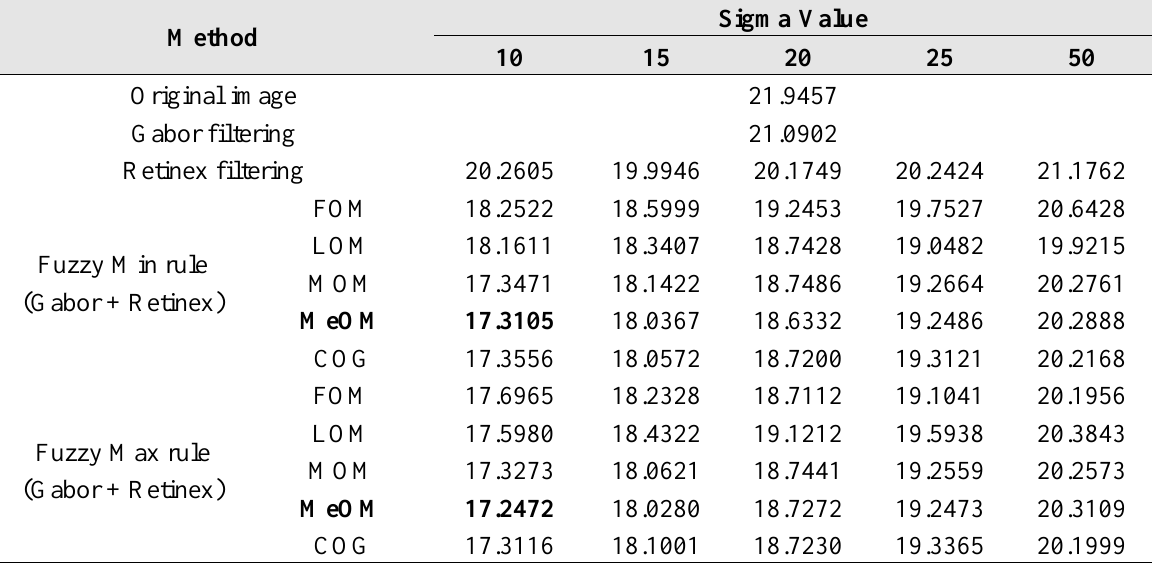
Table 6. Recognition accuracy of the proposed method with Gabor filtering and Retinex filtering, with various sigma values, and a Haar wavelet in terms of the EER for images from database I (unit: